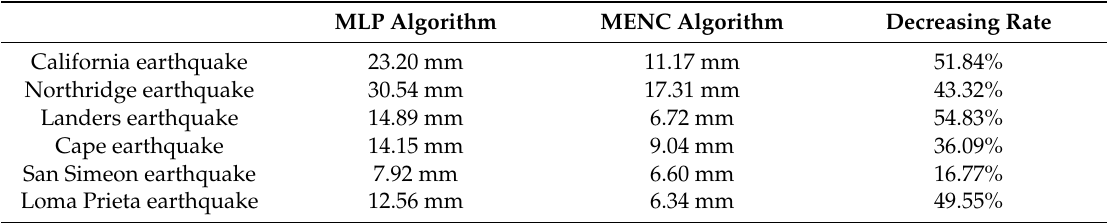
Figure 6. Time-histories of structural displacement response under different control algorithms: ( a ) California earthquake; ( b ) Northridge earthquake; ( c ) Landers earthquake; ( d ) Cape earthquake; ( e ) San Simeon earthquake; ( f ) Loma Prieta earthquake. Table 2. Comparison of the maximum displacement at the third floor according to the algorithms applied to the AMD system under seismic loads (MLP vs. MENC)